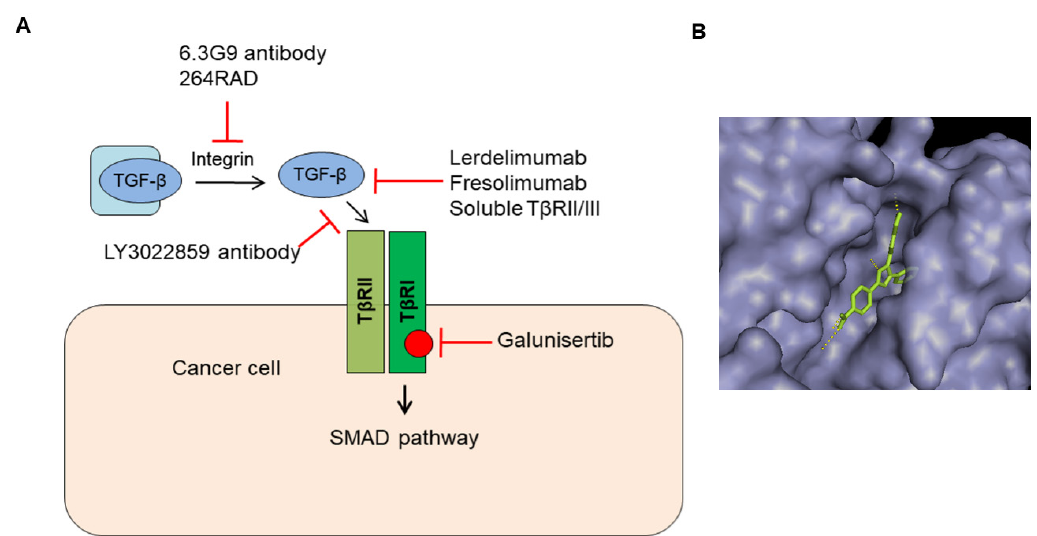
Figure 5. Targeting TGF- β signaling in cancer. ( A ) Various TGF β signaling inhibitors including neutralizing antibodies, ligand traps, and receptor kinase inhibitors are depicted. ( B ) The structure of T β RI kinase (gray) with its ATP competitive inhibitor: a 5,6-dihydro-4H-pyrrolo[1,2-b]pyrazole analogue (green) (Accession code:1RW8) [82].